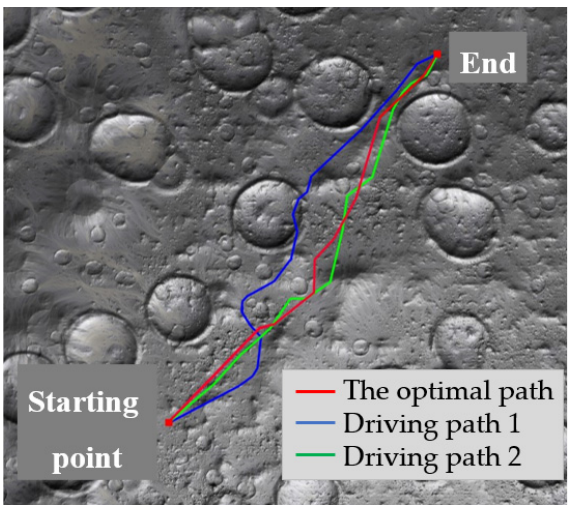
Figure 22. Comparison of experimenters’ driving routes.